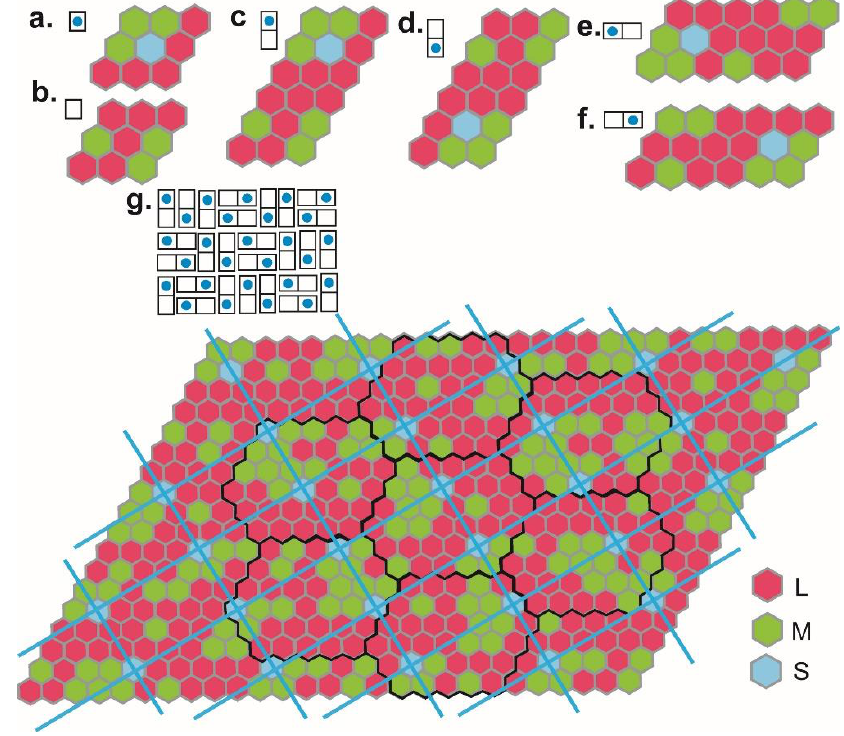
Figure 5. The 2D visual mosaic. ( a ) The basic structural element. ( b ) The supplementary structural element. ( c ) A direct orientation panel. ( d ) An inverted orientation panel. ( e , f ) horizontal replicas of the direct and inverted orientation panels. ( g ) A 2 × 3 panel [42] obtained using the direct paths and all the permutations. In the upper left, the tiling combination algorithms are given. Short (S), medium (M) and long (L) cone cell sensitivity is represented by the corresponding colors: red (620–750 nm), green (500–570 nm) and blue (450–500 nm), respectively. The cone cells exhibit higher density in the central region of the retina, more exactly within an area of 5.5 mm in diameter [36] of the macula. The cone cells are sensitive to short (S), medium (M) and long (L) wavelength regions within this visible electromagnetic spectrum, being called accordingly S, M and L cells [43]. These regions are: blue (450–500 nm), green (500–570 nm) and red (620–750 nm), according to the color they represent. The correspondence between color and cone cell sensitivity is used in Figures 5 to 7 to repre- sent the configurations of artificial photosensitive cells (i.e., pixels or photodiodes). We state the retinal structure is the following [44]: 11.11% S type cells, 33.33% M type cells and 55.56% L type cells. Roughly, the retinal structure cell ratio is 1S:3M:5L, hence each basic structural element able to perceive the complete visible spectrum would be composed of nine or eighteen cone cells in the same ratio (Figure 5a–f). To reach the pro- portions specific to the human retina, it is necessary to add a supplementary structural element, comprised of nine cells, with the ratio 3M:6L (Figure 5b). Together, basic and supplementary structural elements contain 18 cone cells (Figure 5c–f), with the frequency ratio 1S:6M:11L, corresponding to the proportions of 5.5% S type, 33.33% M type and 61.11% L type matching those described by retinal morphology [45]. Morphological studies have revealed the mean proportion of the cone cell types (all at 1° eccentricity) to be: L 62.97% ( ± 3.396%), M 31.31% ( ± 3.396%) and S 5.72% ( ± 0.69%) [45]. It is currently considered that in the FV central region, the M and L cone cell type distribution appears to be a nonrandom structure in some individuals [46], while the S type is more regular than would be expected randomly [45,47], being completely absent in the very center of the FV in a region of about 0.34°. The latter feature makes the FV an area of maximal visual acuity enhanced by the macular elliptical isodensity contour [40].